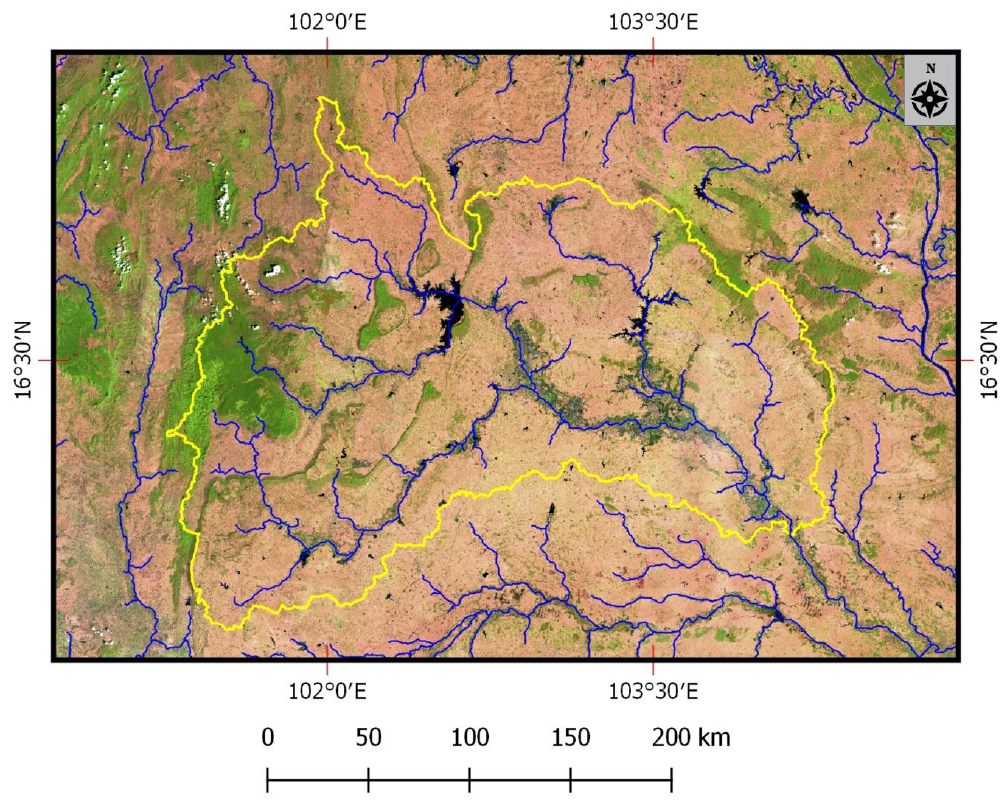
Figure 6. Circa 2010 Landsat TM mosaic of study area (yellow), based SWIR-1 (1.65 micron), NIR, and red reflectance bands loaded into the RGB color guns. The waterways (in blue) are included to aid interpretation.